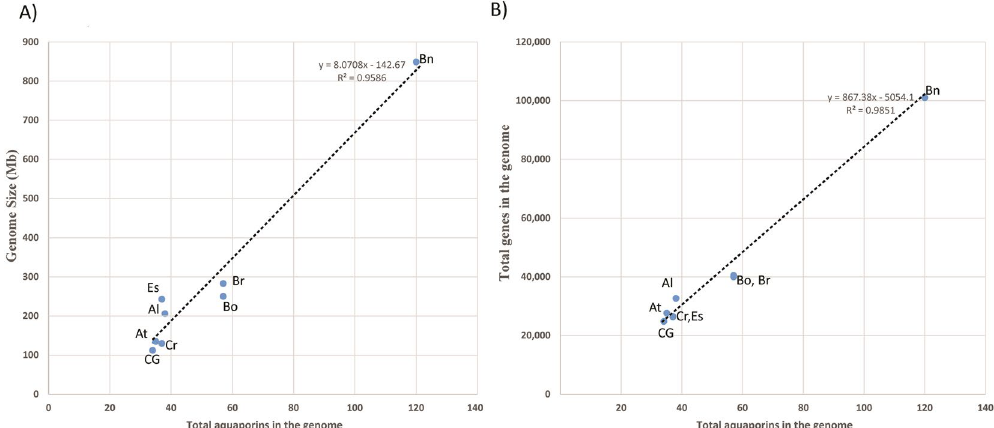
Figure 1. Relationship between number of aquaporins (AQPs), genome size and total number of predicted genes in the genomes. Total AQPs identified in Arabidopsis thaliana (At), A . lyrata (Al), Capsella grandiflora (Cg), C . rubella (Cr), Eutrema salsugineum (Es), Brassica rapa (Br), B . oleracea (Bo) and B . napus (Bn) was plotted against ( A ) the genome size and ( B ) total number of predicted genes.